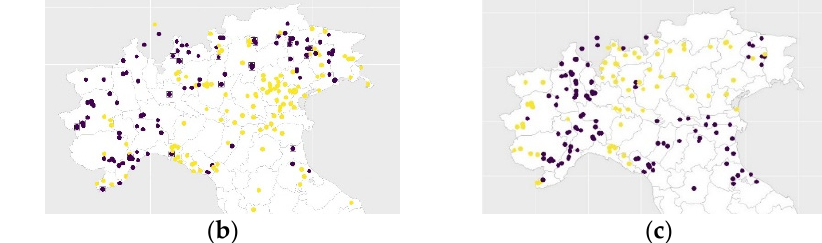
Figure 4. Recapitulative maps (purple = presence; yellow = absence): ( a ) expletive subject clitics with weather verbs; ( b ) subject clitics doubling who ; and ( c ) subject clitic at the first person